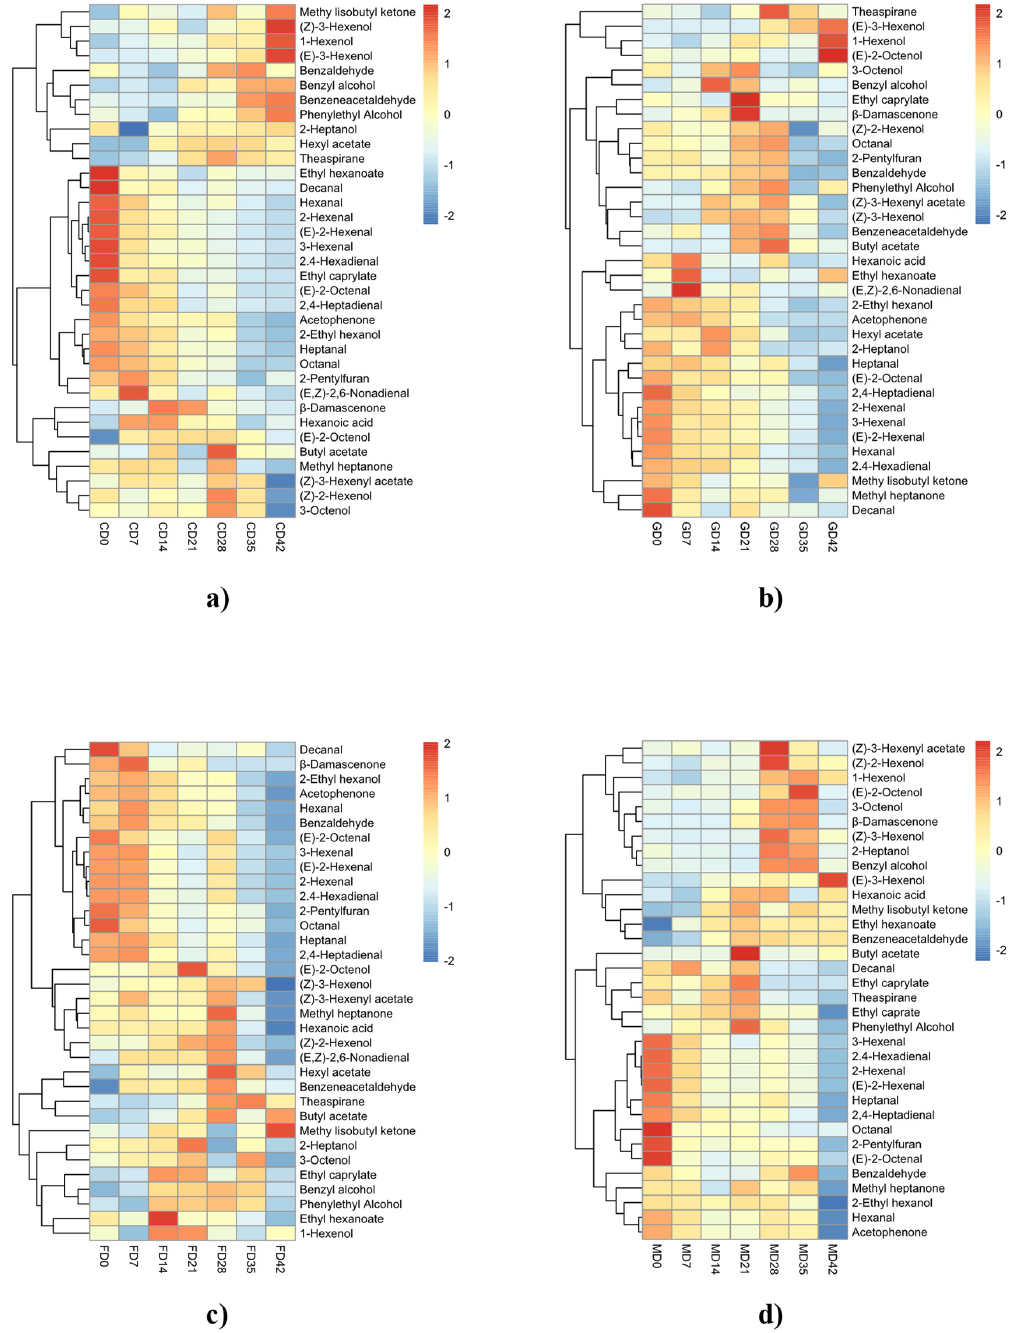
Figure 1. Clustering heat map of free volatile compounds during grape ripening. (( a ), Cabernet Sauvignon; ( b ), Cabernet Gernischet; ( c ), Cabernet Franc; ( d ), Merlot.). The aromas of wine grapes in the D0–D7 period were dominated by carbonyl com- pounds and showed a decreasing trend during grape ripening. Among the first category compounds, C6 aldehydes were predominant, including 1-hexenal, 3-hexenal, 2-hexenal, (E)-2-hexenal and (E,E)-2,4-hexadienal. These compounds all had the maximum content in the D0–D7 period, which is just the source of green aromas in the unripe berry. During grape maturation, C6 aldehydes are formed from fatty acids. Fatty acids such as linoleic acid and linolenic acid are oxidized by lipoxygenase (LOX) and lipid hydroperoxide lyase